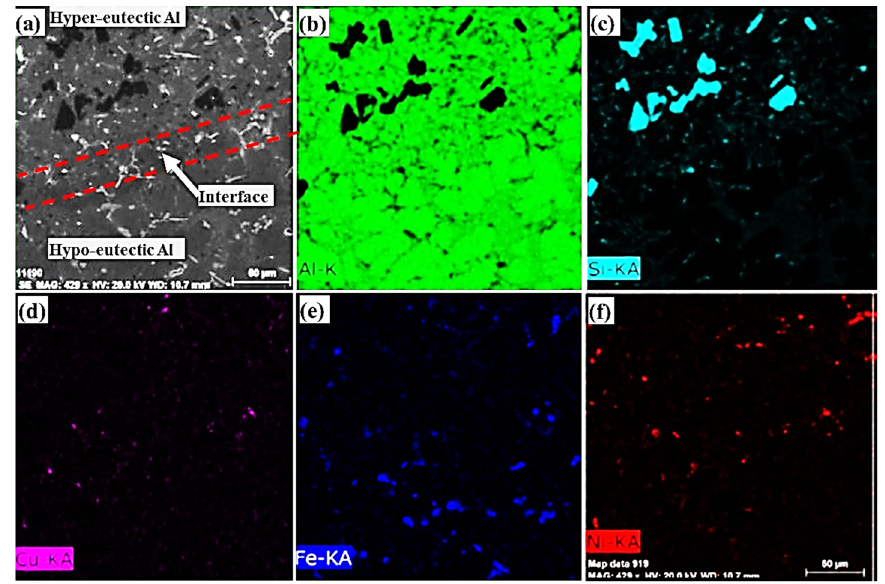
Figure 5. ( a ) SEM micrograph and concentration mappings of ( b ) Al, ( c ) Si, ( d ) Cu, ( e ) Fe, and ( f ) Ni for the Al/Al bimetal casting in the metallic mould using a 10 s time interval.